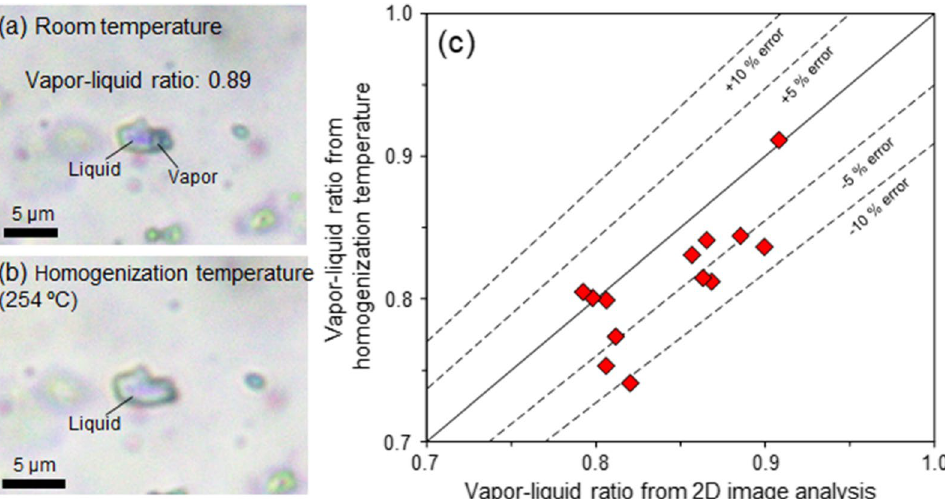
Fig. 1 Photomicrographs of primary two-phase fluid inclusion at room temperature ( a ) and at homogenization temperature ( b ). Water density (liquid–vapor ratio) of the fluid inclusion was calculated to be 0.89 and 0.84 g cm − 3 from 2D image analysis with Eq. (1) and homogenization temperature of 254 °C with LonerHGK (http:// fluids. unile oben. ac. at). ( c ) Comparison of vapor–liquid ratio calculated from 2D image analysis and homogenization temperature for fluid inclusions trapped in shear and extension